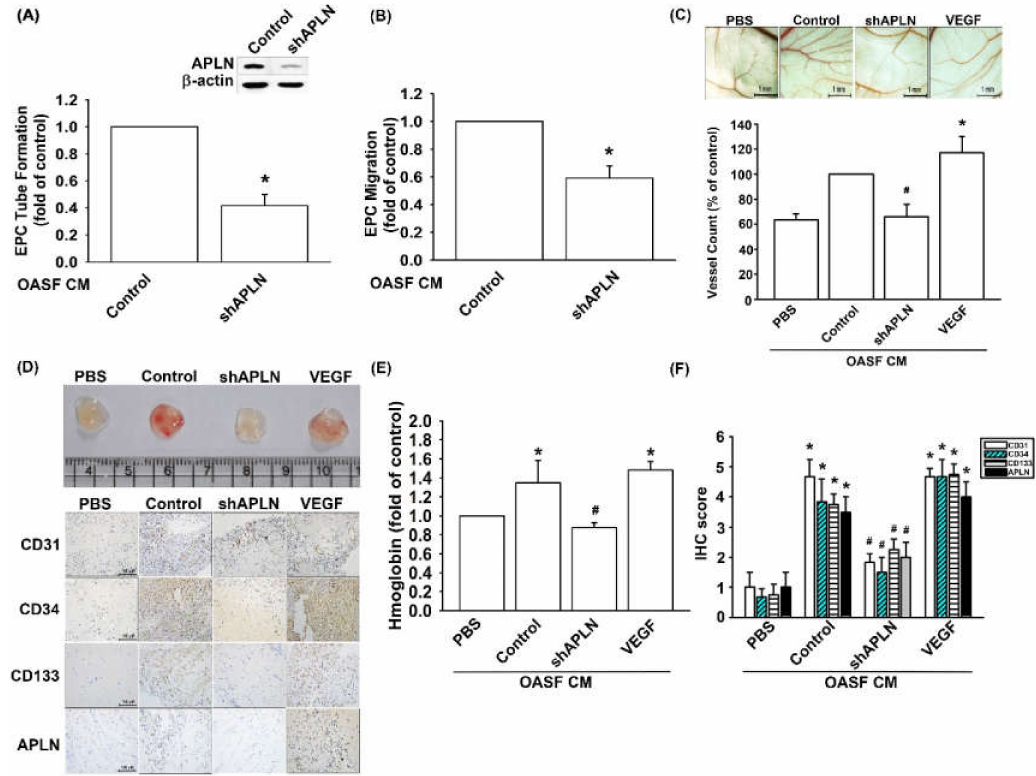
Figure 6. APLN knockdown in OASFs decreases VEGF-dependent angiogenesis. ( A , B ) Culture medium from control-shRNA and shAPLN-transfected OASFs was applied to EPCs for 24 h; EPC capillary-like structure formation and cell migration was examined using tube formation ( n = 5) and migration assays ( n = 5). ( C ) The harvested culture medium was applied to 6-day-old fertilized chick embryos for 4 days. Chorioallantoic membranes (CAMs) were then examined using microscopy and photographed, and vessels counted ( n = 3). ( D ) Matrigel plugs containing the harvested culture medium were subcutaneously injected into the flanks of nude mice ( n = 6). ( E ) After 7 days, the plugs were photographed, and hemoglobin levels were quantified. ( D ) Plug specimens were immunostained with antibodies against CD31, CD34, CD133, and APLN and ( F ) quantified using the IHC score. * p < 0.05 compared with control; # p < 0.05 compared with the APLN-treated